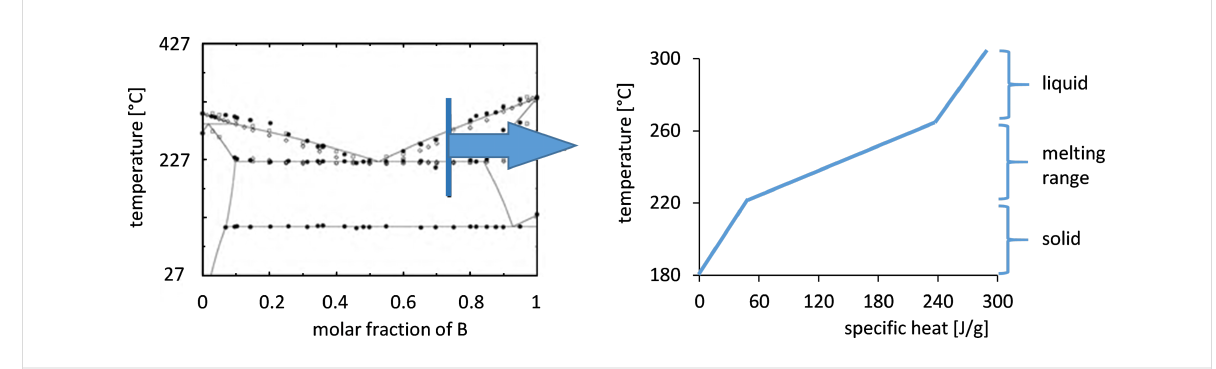
Figure 12: Phase diagram of KNO 3 –NaNO 3 [34] and the phase dependent enthalpy increase during thermal charging of the selected salt mixture (30 wt % KNO 3 + 70 wt % NaNO 3 ).